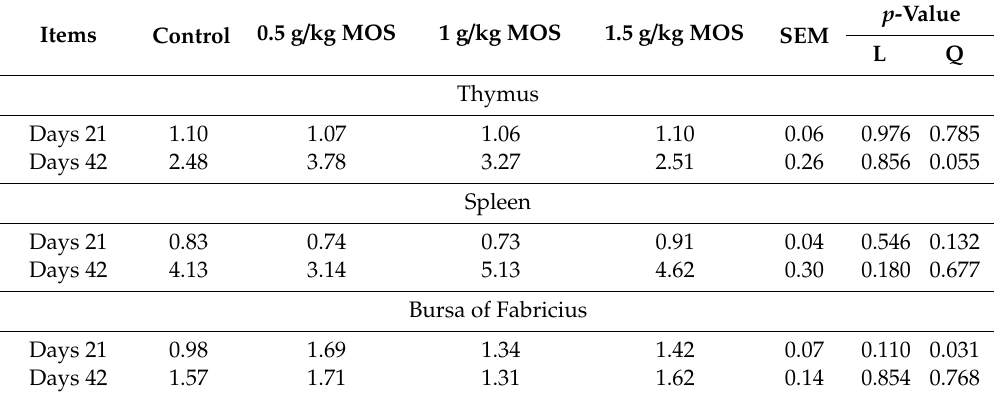
Table 3. Immune organ weights from Partridge Shank chickens fed diets supplemented with or